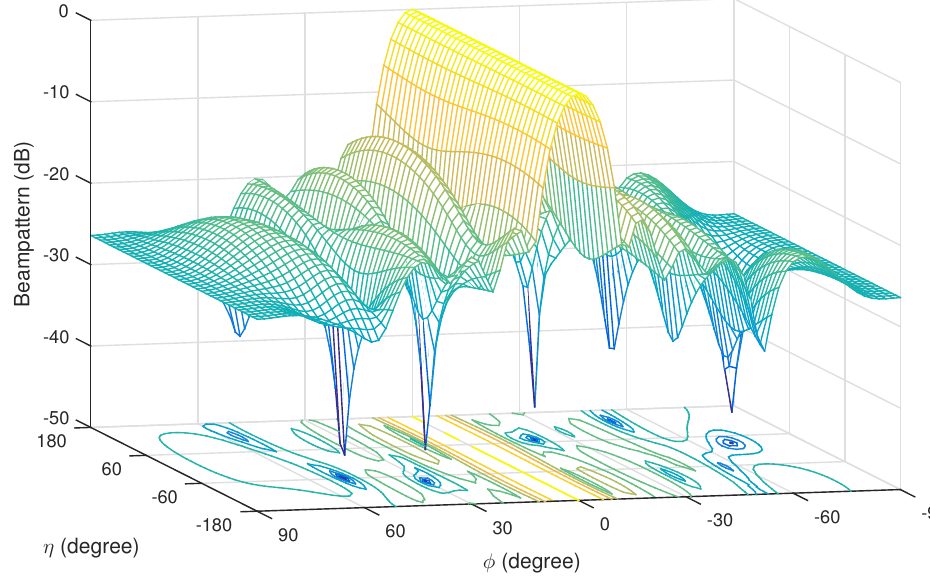
Figure 2. Beam pattern obtained from the full Q-Capon beamformer with θ = 90 ◦ and γ = 60 ◦